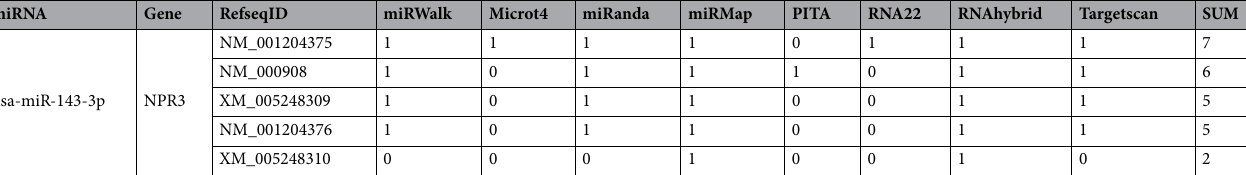
Table 1. Identification of miR-143-3p targeting the NPR3 3 ′ UTR. The number of miR-143-3p predicted target sites on NPR3 3 ′ UTR from 8 web-based microRNA target prediction algorithms.